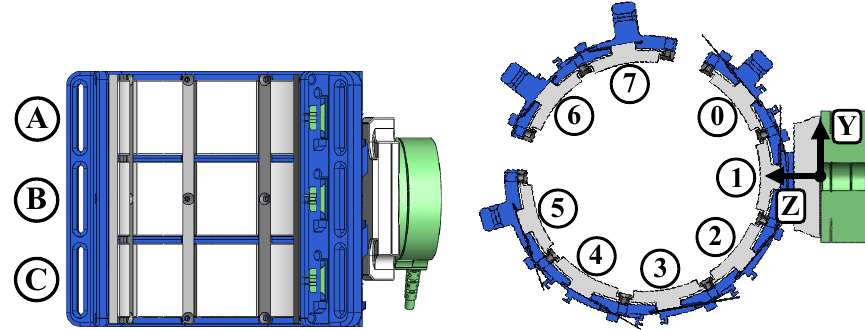
( b ) Cross section view of the cuff. Figure 6. Sensor placement on the cuff is distributed across three rows and eight columns. Foam padding is not shown in these images. The orientation of the six-axis load cell can be seen in Figure